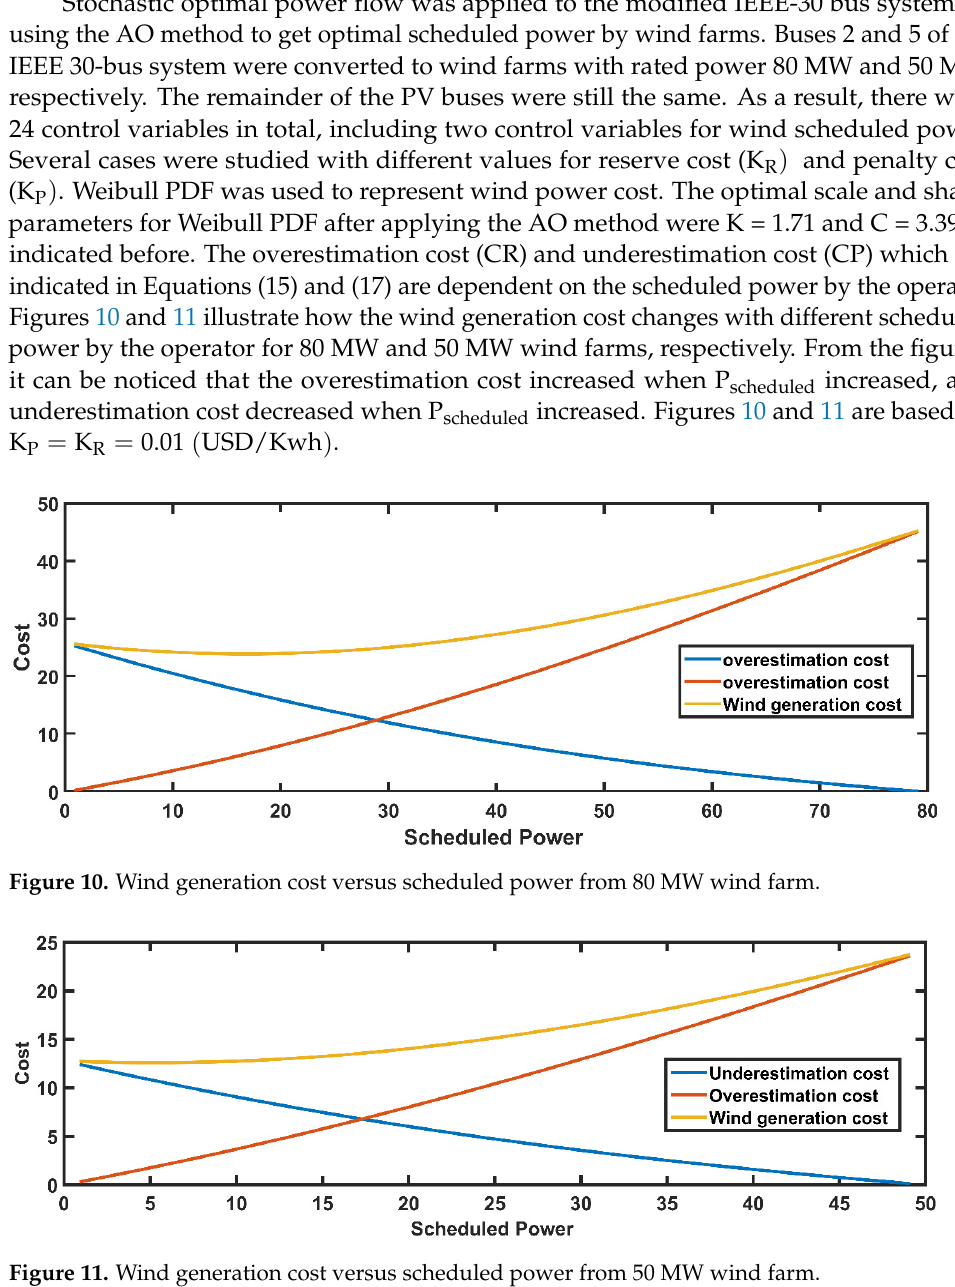
Table 5. Result comparison for OPF IEEE ‐ 118 bus system.